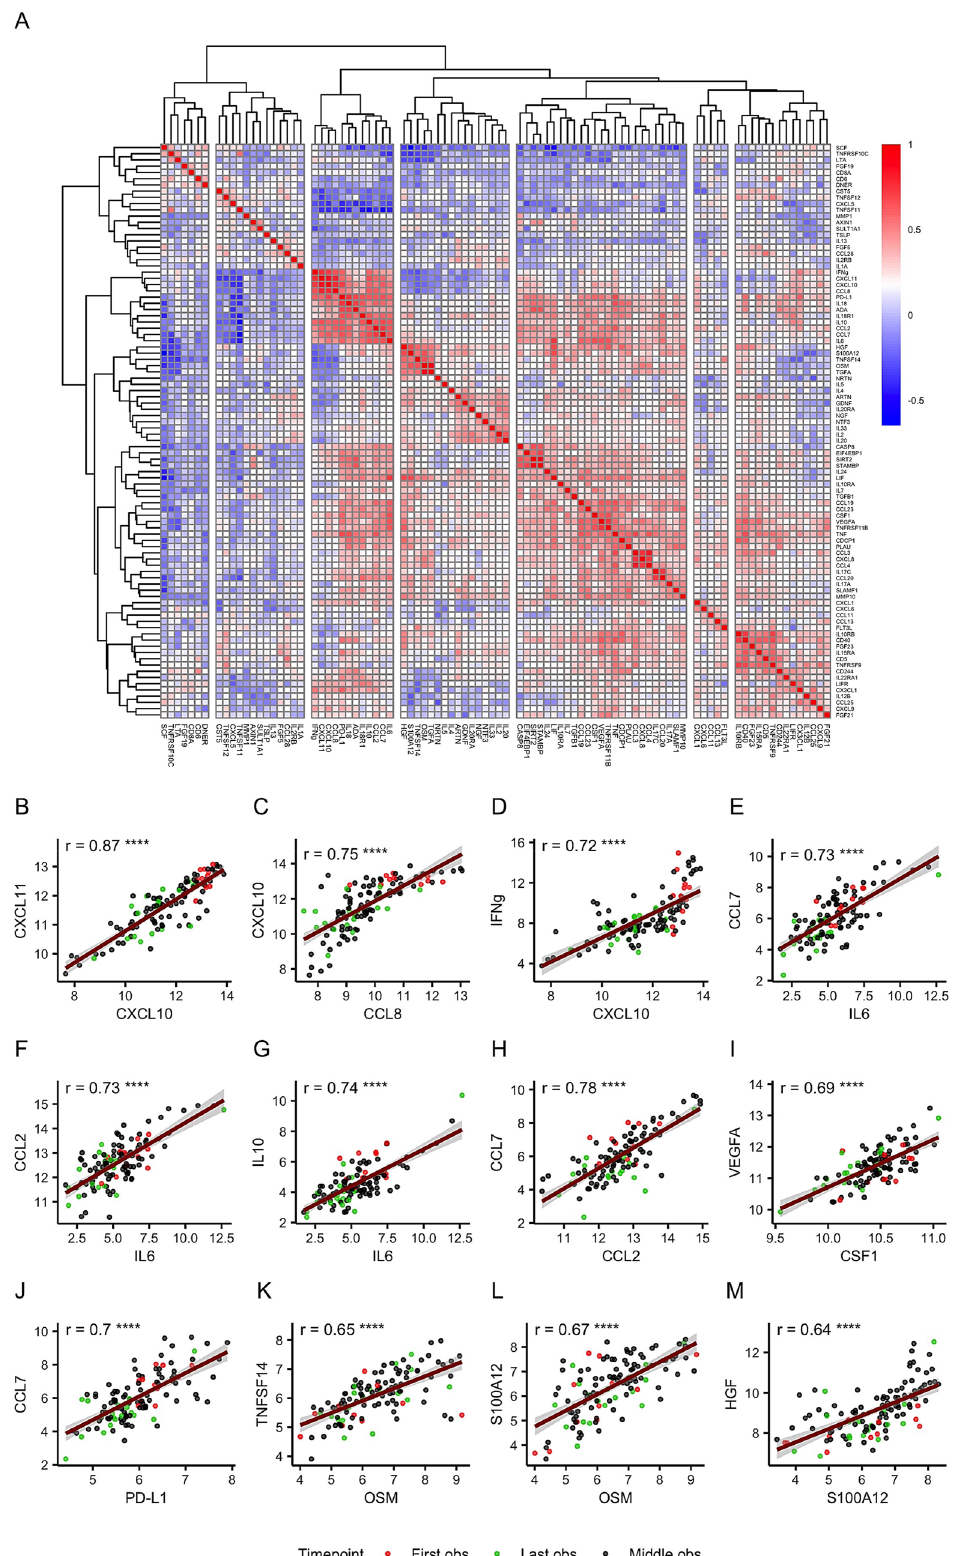
Figure 4. Cluster analysis of plasma protein correlations values. ( A ) The heatmap of seven distinct clusters based on Spearman’s correlation matrix from all PEA analysis NPX measurements based on hospitalized patient data . ( B – M ) Scatterplots of pairwise Pearson correlations of selected PEA measurements. Linear regression line shows overall trend between two measurements and individual observations are colored according to the sampled timepoints; at the hospitalization (first observation, red), before leaving the hospital or passing away (last observation, green) or between those aforementioned timepoints (middle observation,